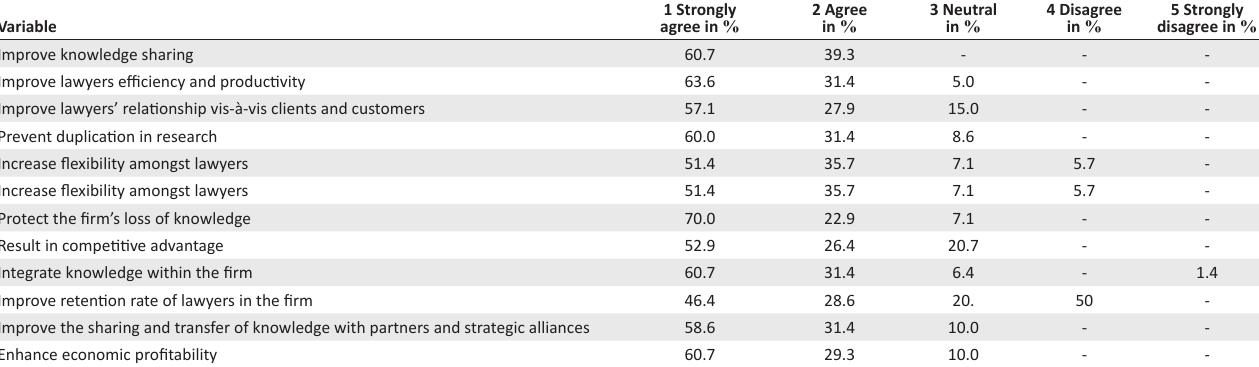
TABLE 2: The perceived benefits of knowledge management in law firms in Botswana ( N = 140).